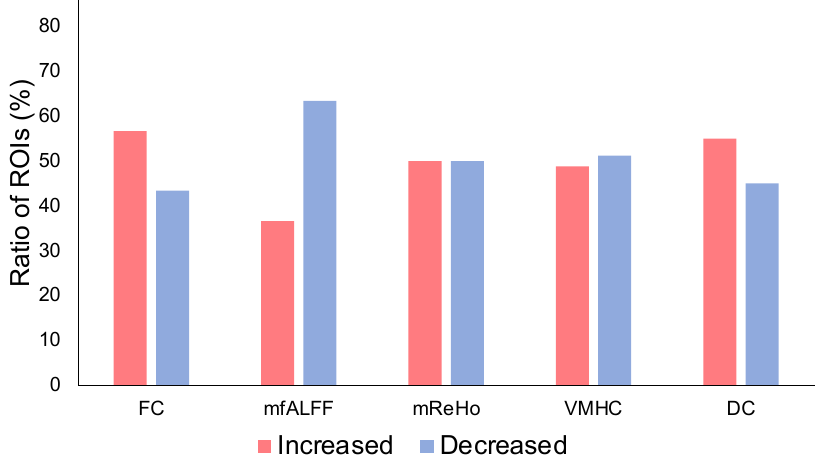
Figure 3. Ratio of ROIs with increased ICC values and with decreased values after the correction. The mean ICC values, before and after correction, are shown in Figure 4. The mean ICC difference for all ROIs between the corrected and the uncorrected was significant for FC (paired t ‐ test; p = 0.01), with an ICC increase of 3.5% after correction. The mean ICC value difference for all ROIs between the corrected and the uncorrected was significant for fALFF (paired t ‐ test; p = 0.01), with an ICC decrease of 4.8%. The mean ICC differences for the other metrics, ReHo, VMHC, and DC, were not significant (paired t ‐ test; p = 0.43, 0.41, 0.22, respectively).